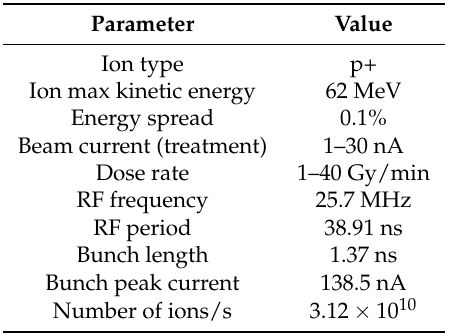
Figure 2. Sketch of the CCC proton therapy beamline. The blue box marks the integration zone of the VELO detector modules. They are placed between the modulator box (orange) and diagnostic box (green). The present aluminium pipe will be removed. Adapted from [15]. Table 1. Cyclotron time structure and beam